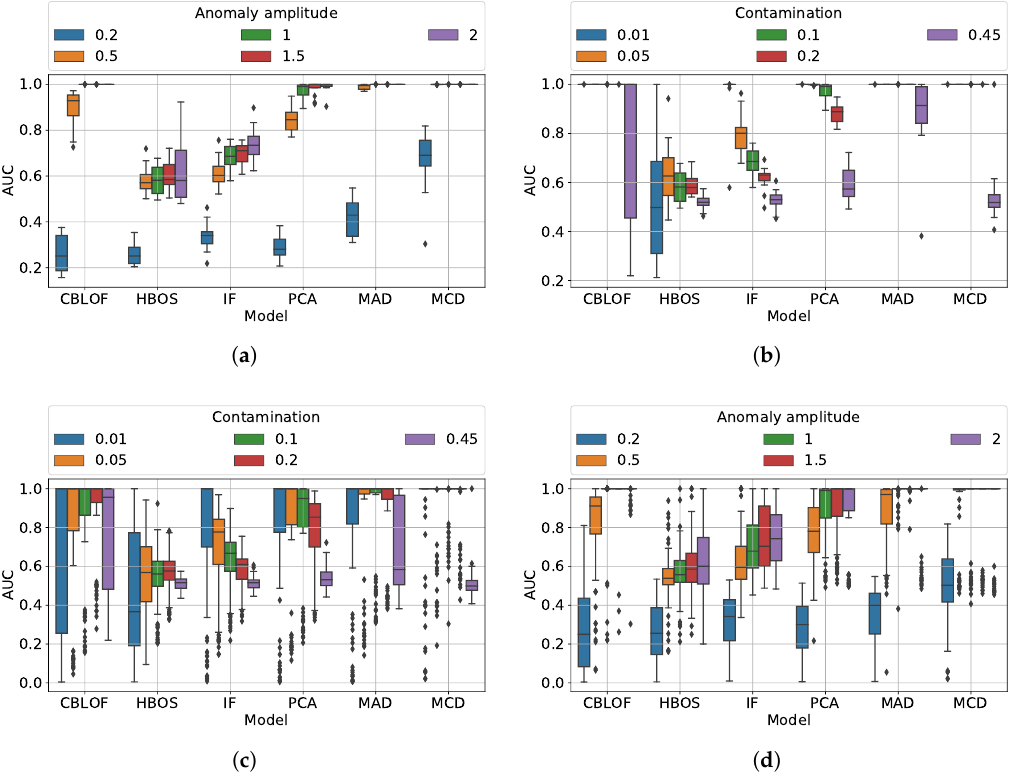
Figure 8. Bias. ( a ) Fixed contamination 10%. The anomaly amplitude varies. ( b ) Fixed anomaly amplitude 1. The contamination varies. ( c ) General case, where both the anomaly amplitude and the contamination vary. Contamination view. ( d ) General case, where both the anomaly amplitude and the contamination vary. Anomaly amplitude